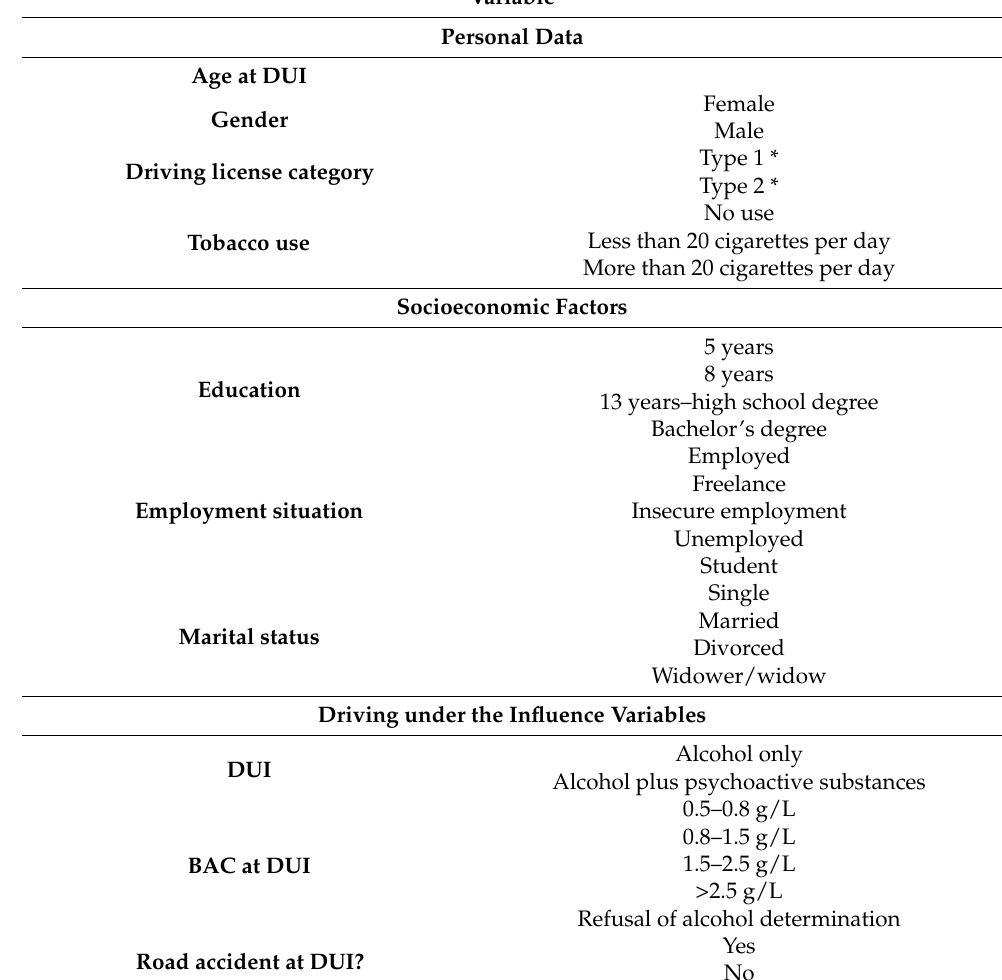
Table 1. Data collected via the study